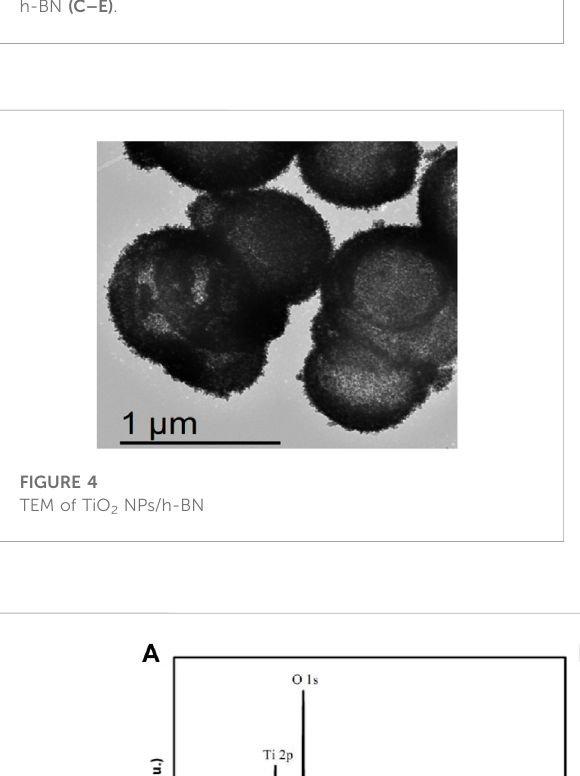
FIGURE 3 SEM of TiO 2 NPs/h-BN (A,B) and EDS of TiO 2 NPs/ h-BN (C – E) .